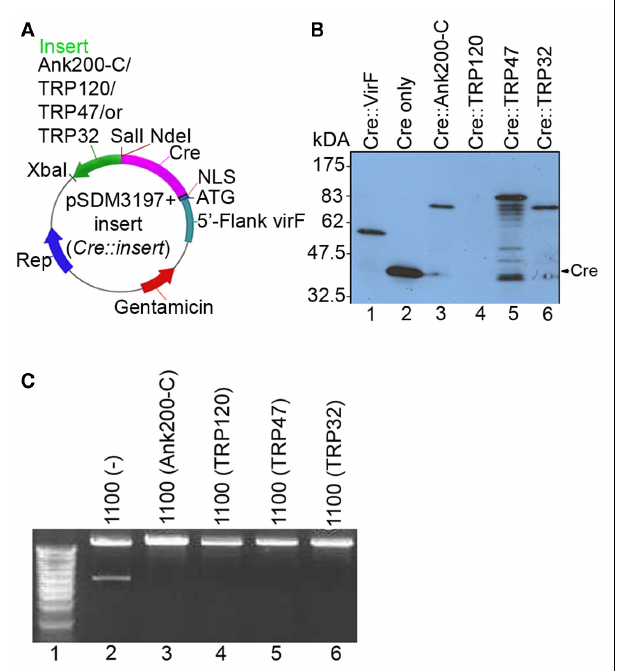
FIGURE 1 | Cloning of Cre:: Ehrlichia in-frame fusion constructs and their expression and Cre activity in A. tumefaciens. (A)